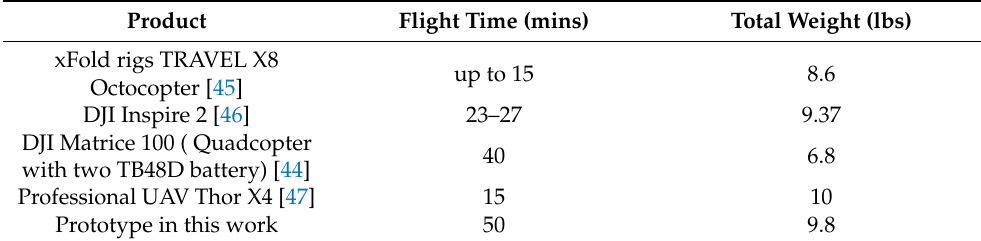
Table 2. Multirotor drones’ flight times.